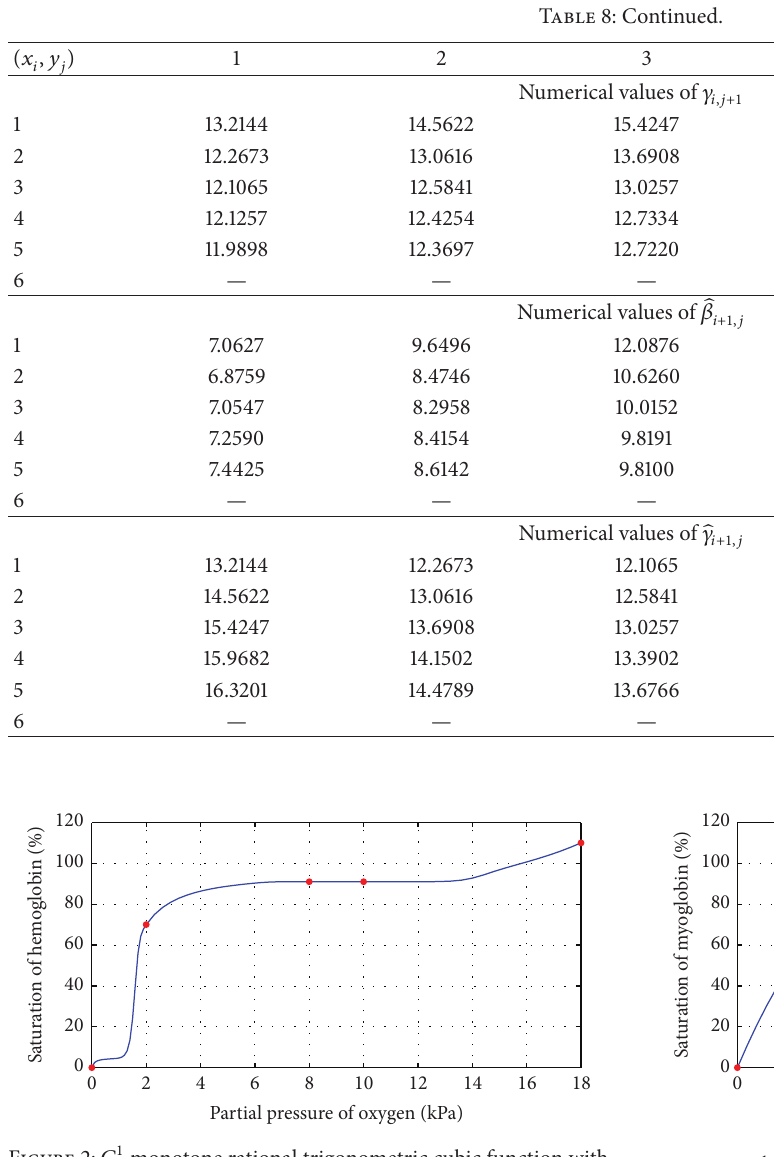
Figure 4: 𝐶 1 monotone rational trigonometric cubic function with = 2.0, 𝛿 = 0.5 . 𝛼 𝑖 𝑖